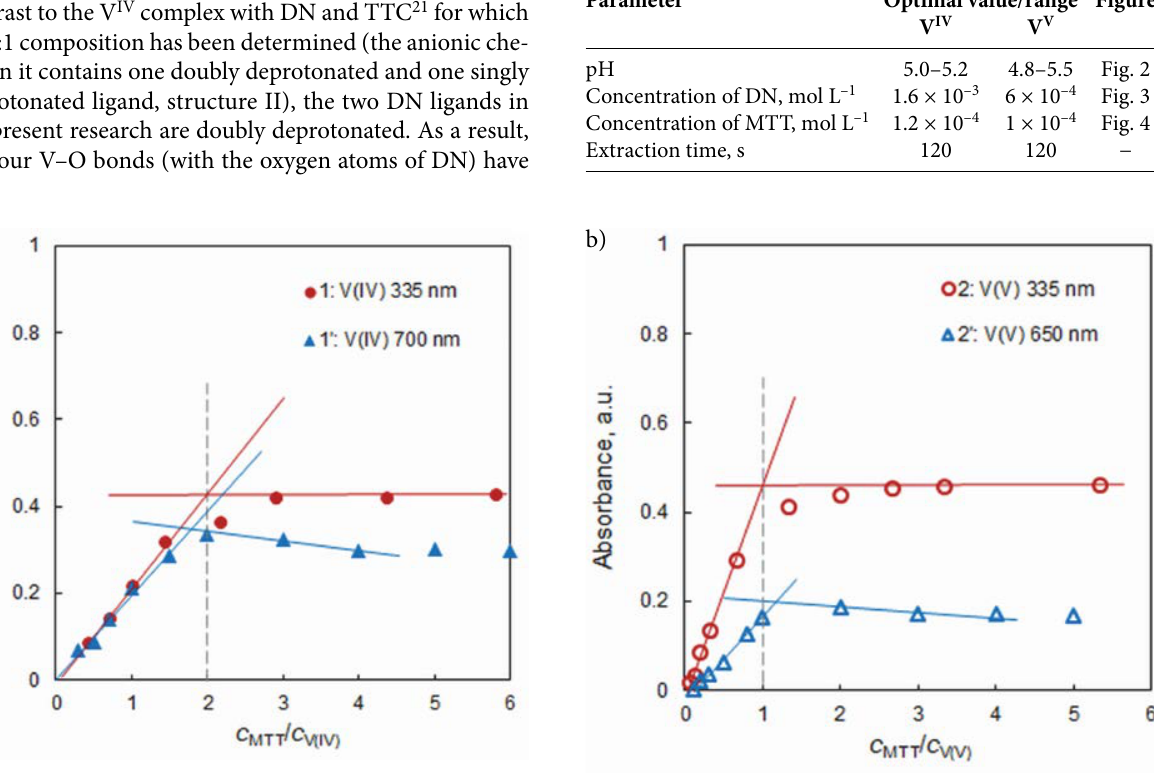
Figure 6. Determination of the МТТ:V IV ( а ) and МТТ:V V ( b ) molar ratios by the Yoe & Jones method.